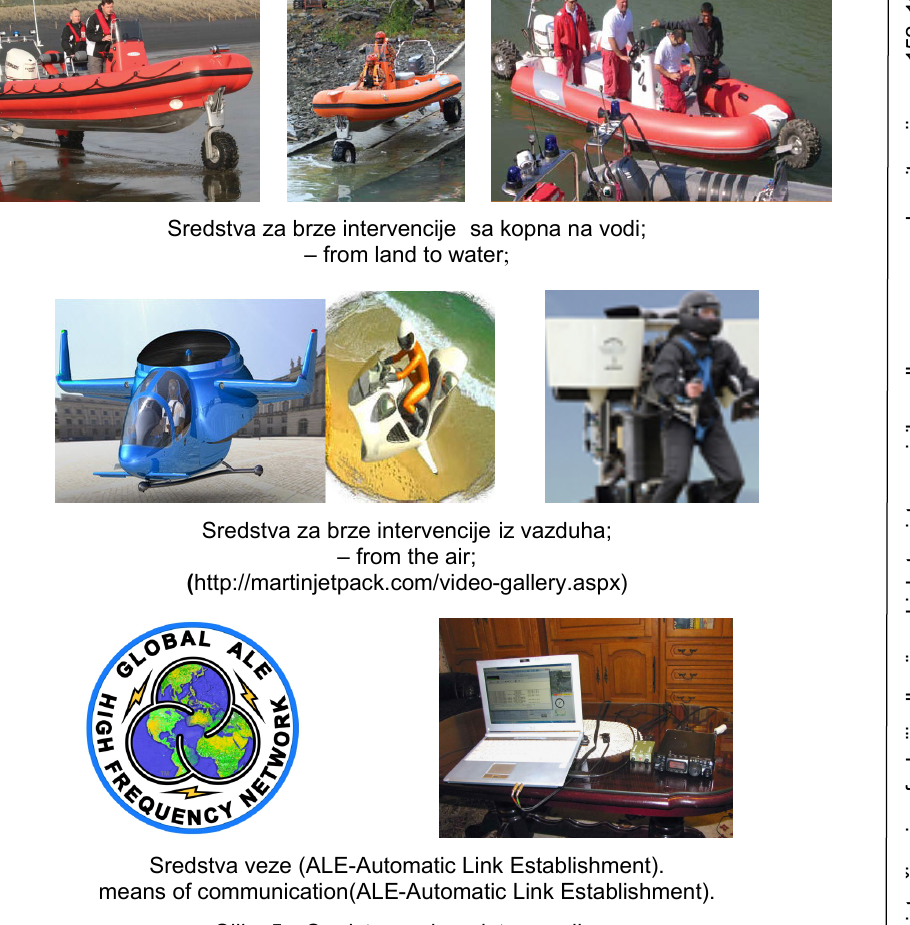
Figure 5 – Means for rapid intervention: